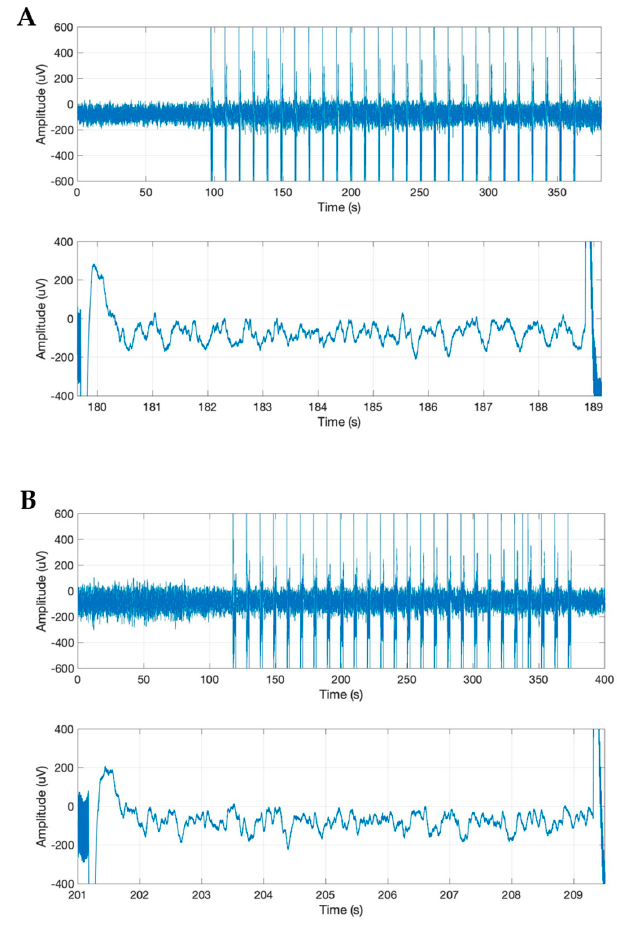
Figure 8. Frontal electrocorticogram (ECoG) features during stimulation of the claustrum surrounding areas showing slow-wave activity with no burst suppression pattern appearance. ( A ) ECoG slow-wave